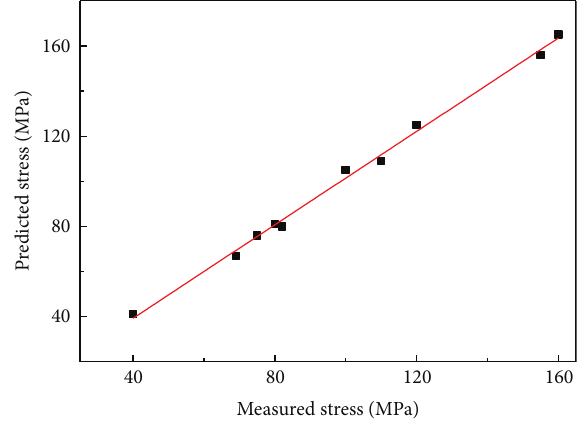
Figure 7: Relationship between strain rate and flow stress for AZ81 magnesium alloy.